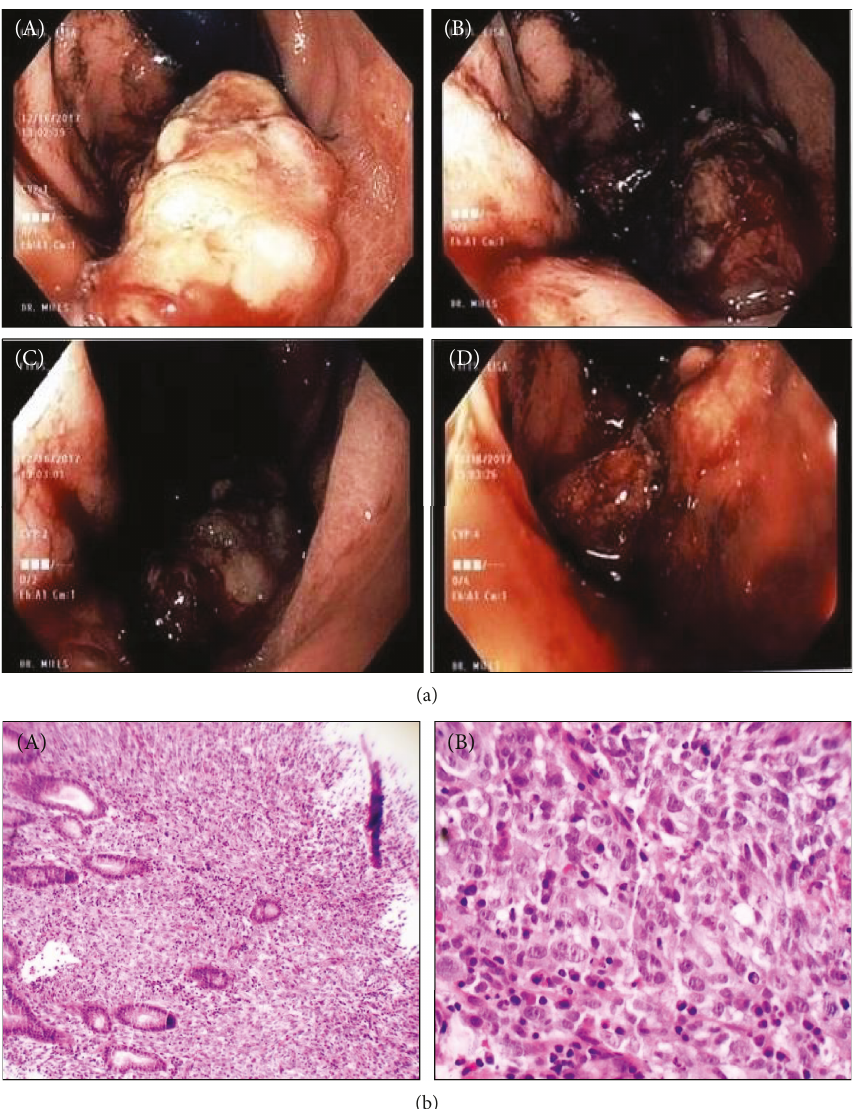
Figures 2: (a) EGD showing lobulated mass measuring at least 3-4 cm in length (A, B) and 2-3 cm in diameter (C, D). (b) H&E staining at lower (4x) and higher magni fi cations (20x) showing characteristics of gastric